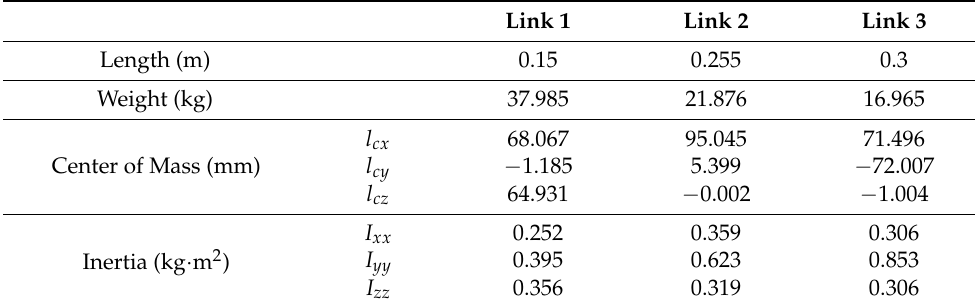
Figure 2. FARA ROBOT AT2 3-DOF robotic mechanical model in SOLIDWORK and its geometrical dimensions. Table 2. The designed parameters of the FARA robot